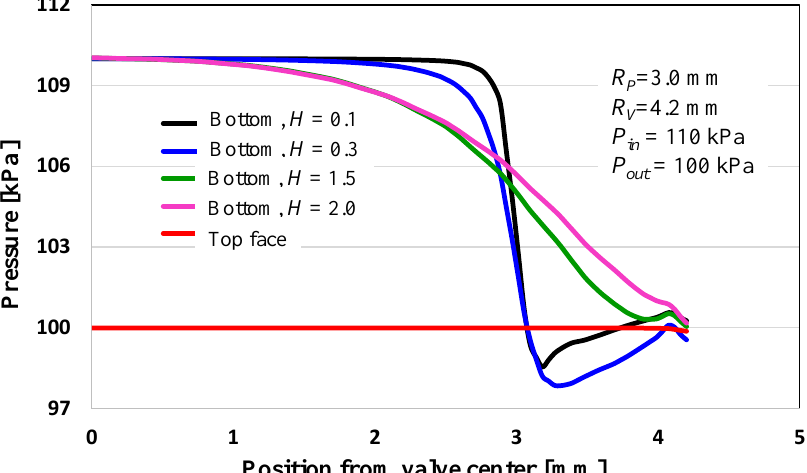
Figure 8. Pressure distributions on top and bottom faces of valve for three cases of valve lift.